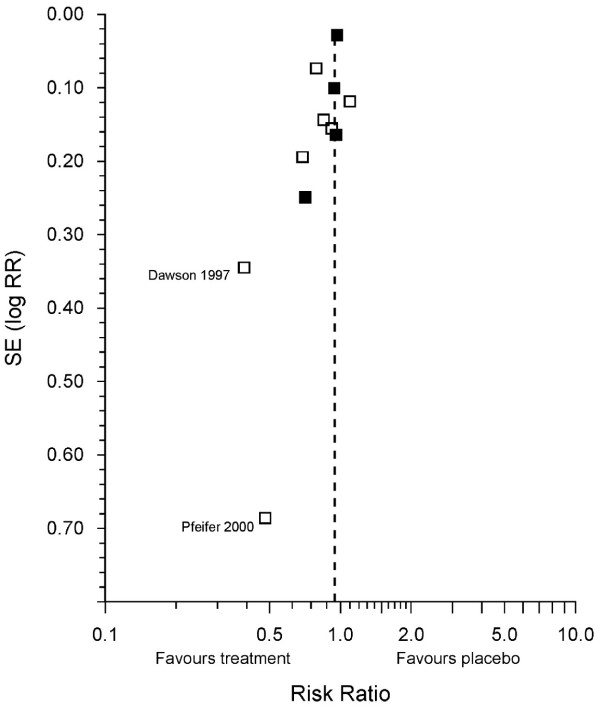
Funnel plot of randomised controlled trials on the prevention of any nonvertebral fracture with vitamin D supplementation. Open symbols: trials included in the meta-analysis. Solid symbols: recent trials. Dashed line: pooled risk ratio (RR, 0.94; 95 percent confidence interval, 0.89 to 0.98).